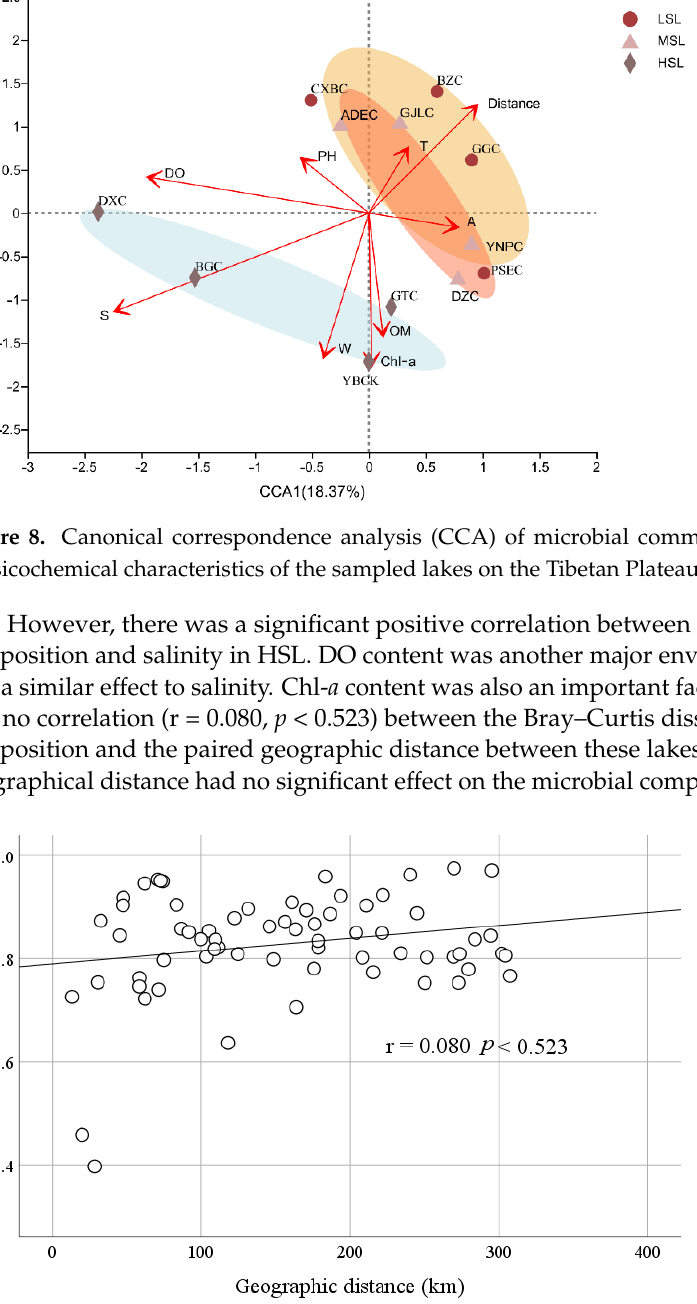
11 of 21 Figure 7. Non-metric multidimensional scaling (NMDS) of microbial community composition in the sampled lakes on the Tibetan Plateau, China. CCA demonstrated that the composition of the lake microbial community was re- lated to salinity, DO content, and chlorophyll content (Figure 8). Among these factors, salinity had the highest explanatory power (18.37%, r = 0.779, p < 0.001). The microbial